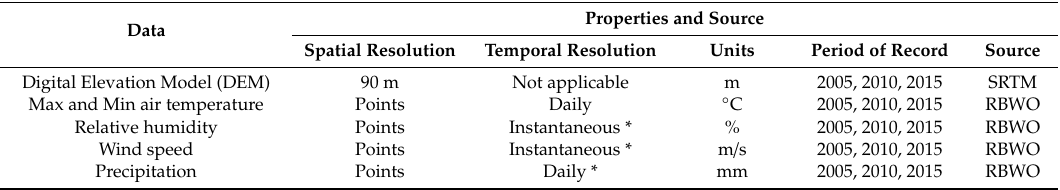
Table 1. Topography (elevation) and meteorological data used in this study. SRTM (Shuttle Radar Topography Mission); RBWO (Rufiji Basin Water Office).